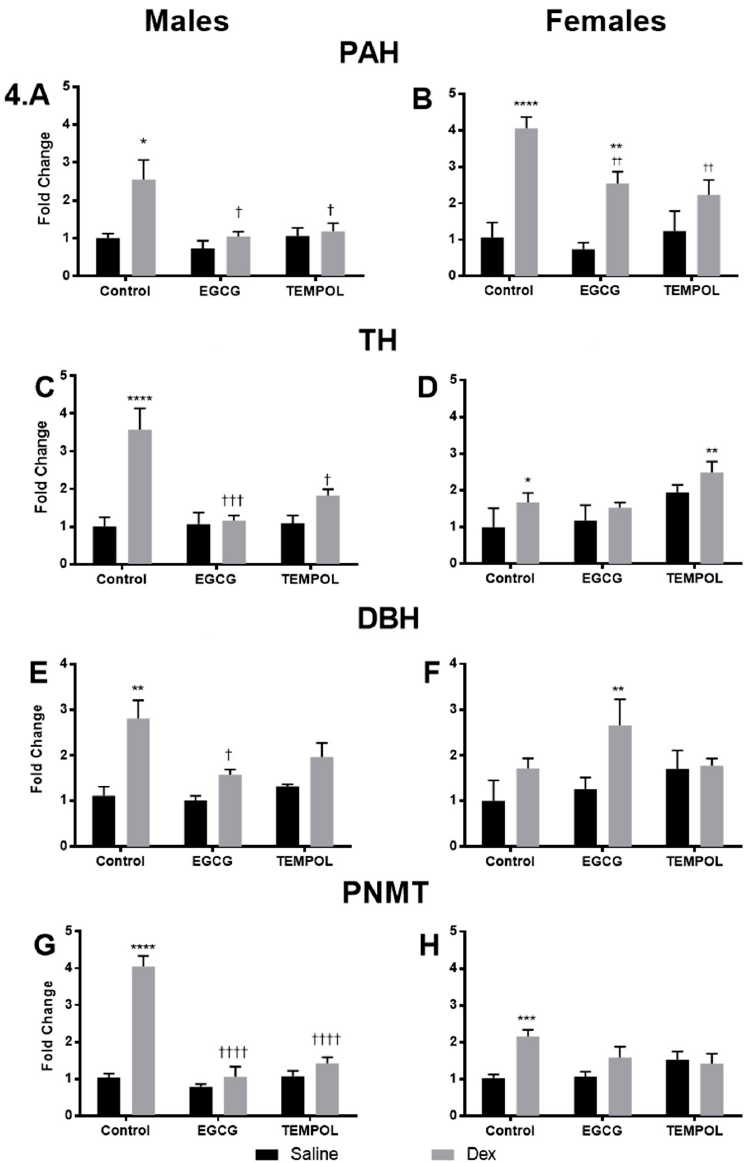
Figure 4. The impact of in-utero antioxidant administration on adrenal catecholamine biosynthetic enzyme expression levels. Quantification of adrenal catecholamine biosynthetic enzyme levels was